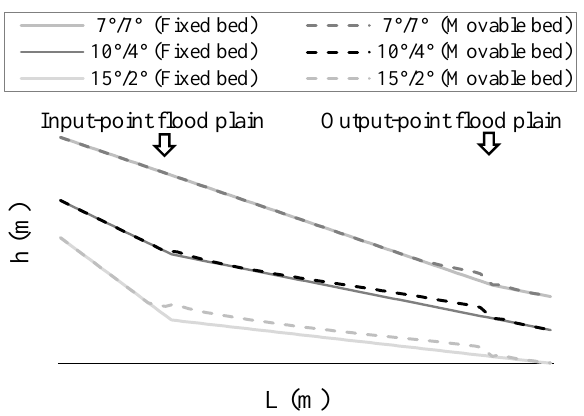
Figure 29. Effect of different gradient changes on sediment shape (longitudinal view).